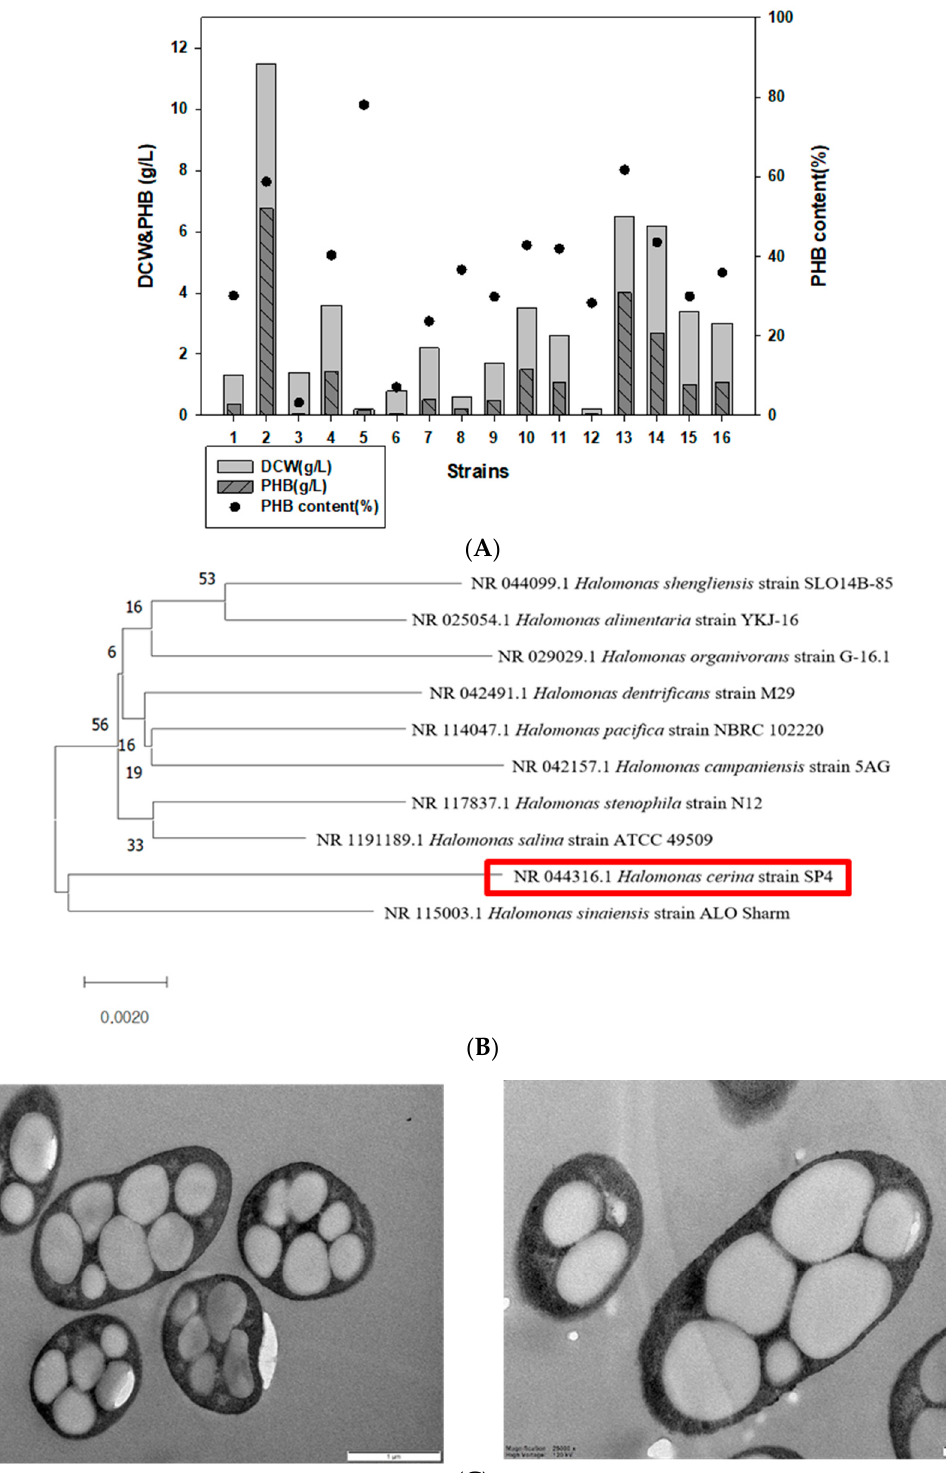
Figure 1. Identification of PHB-producing strains that produce PHB. ( A ) GC analysis comparison of DCW and PHB production in 16 Halomonas strains. ( B ) Phylogenetic analysis using 16S rRNA sequencing of Halomonas sp. YK44. ( C ) TEM image of Halomonas sp. YK44 after being cultured for 48 h at 25 °C in MB medium with 2% galactose, final 4% NaCl, and 0.1% yeast extract (Magnification: Right—16,300×, Left—25,000×).